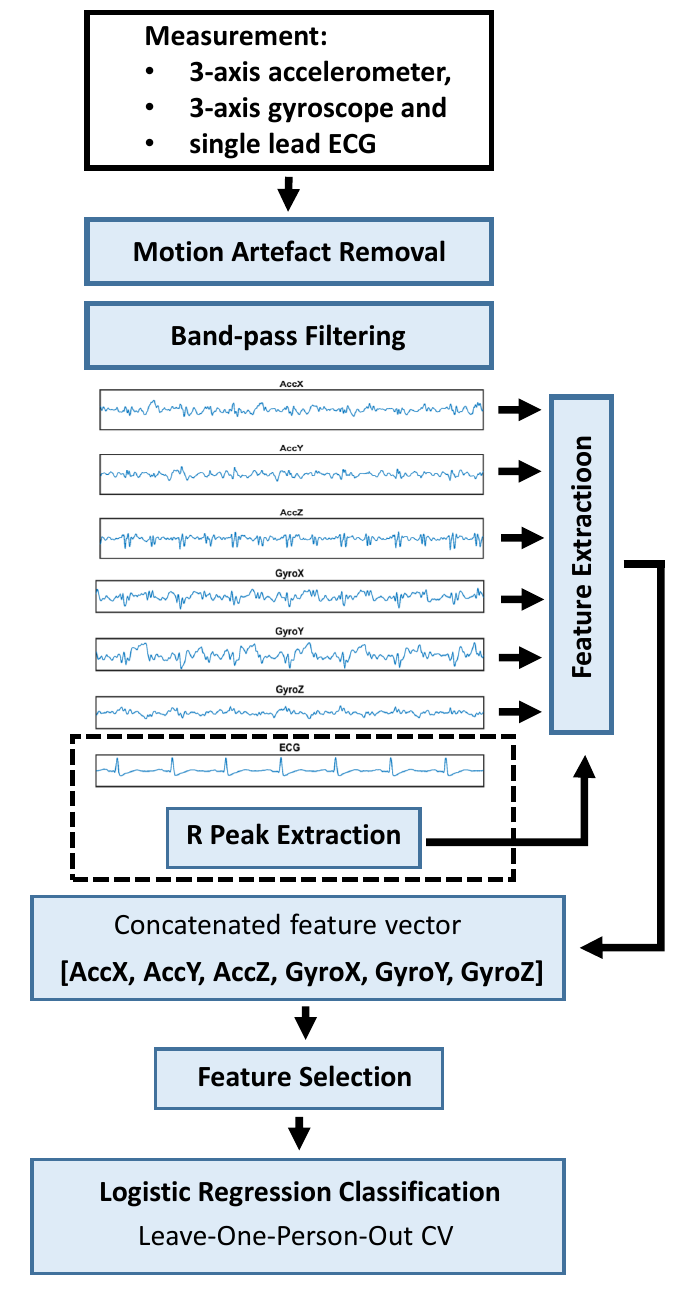
Figure 3. The overall measurement and analysis pipeline. First motion artefact removal selects only the longest connected artefact-free signal portion (in all axes). Then resulting signal was band- pass filtered. ECG R peaks were used to locate heartbeats for feature extraction and three main feature types were analyzed: stability of heartbeat morphology, signal strength and amplitude and time intervals (calculated within specific windows inside each heartbeat and axis). Finally, feature selection and binary classification with logistic regression classifier utilizing cross validation (LOOCV) were